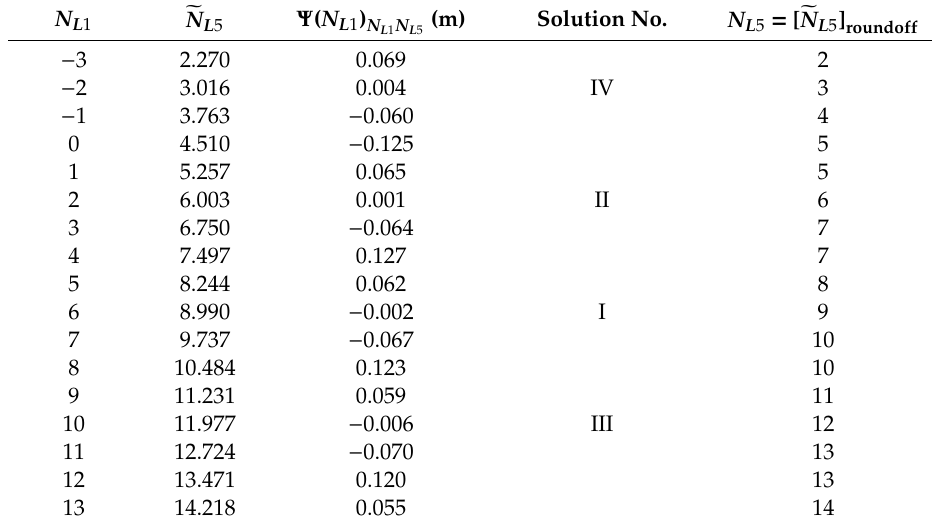
Table 2. The set of integer candidates based on the function Ψ ( N L 1 ) (cid:101) N L 5,0 = 8.349, where N L1,i ∈ < − 3;13 >